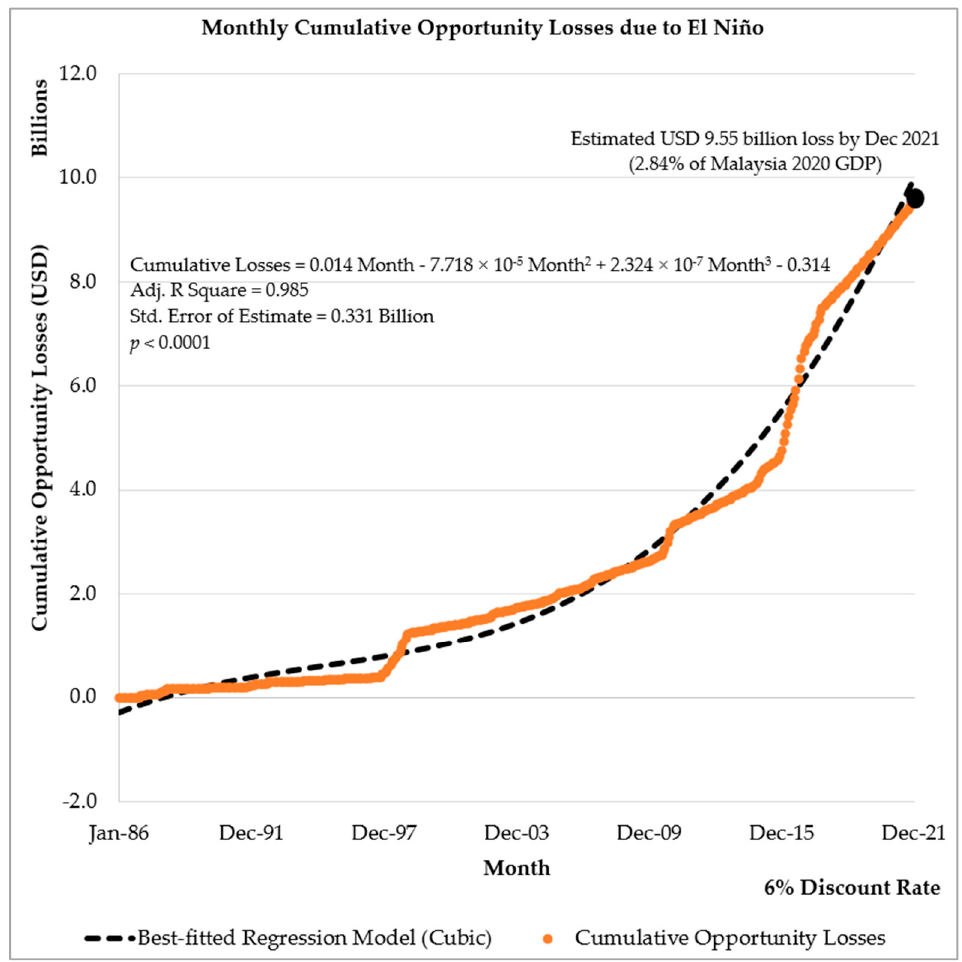
Figure 5. Monthly cumulative opportunity losses in the Malaysian oil palm industry due to El Niño projected to December 2021.